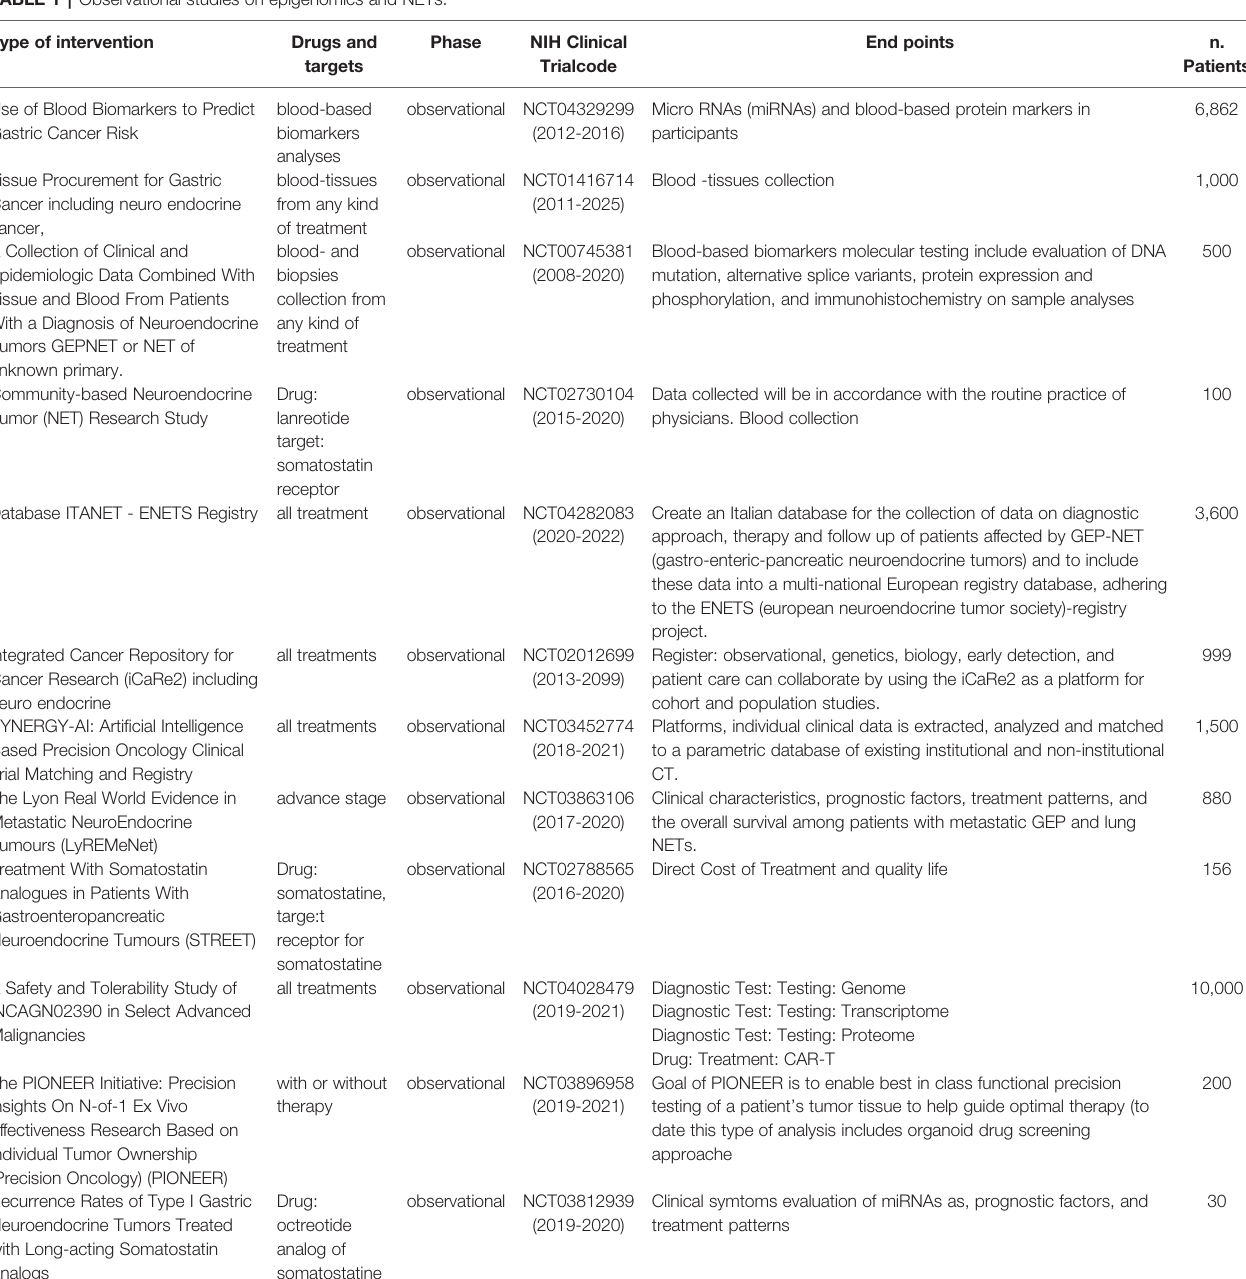
TABLE 1 | Observational studies on epigenomics and